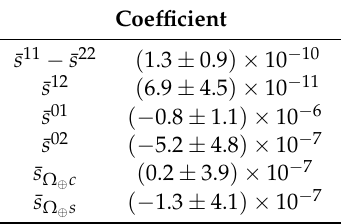
Table 2. Estimation of Standard-Model Extension (SME) coefficients from Lunar Laser Ranging (LLR) postfit data analysis from [45]. No correlations coefficients have been derived in this analysis. The coefficients ¯ s ij are projections of the ¯ s IJ into the lunar orbital plane (see Equation (107) from [39])